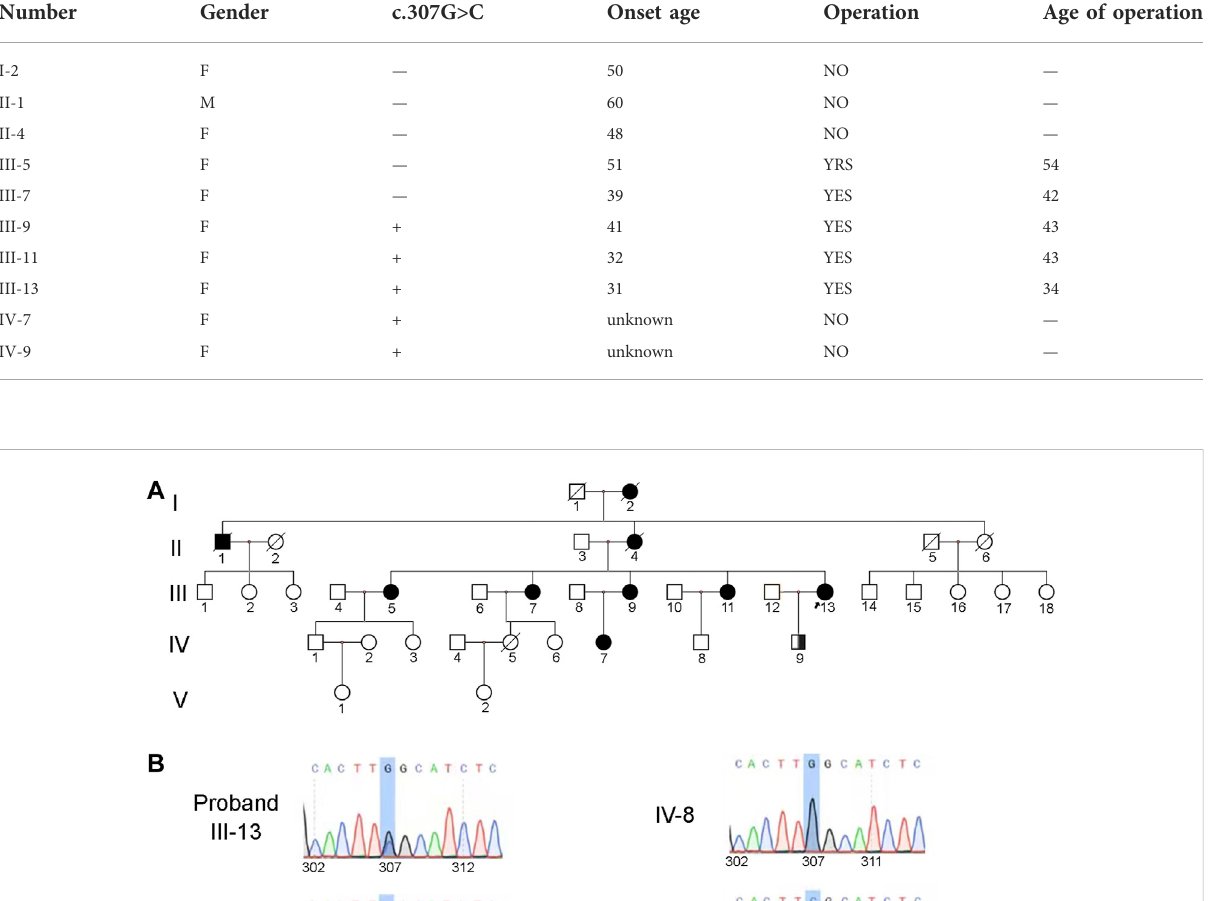
TABLE 1 Clinical phenotype in each affected subjects.